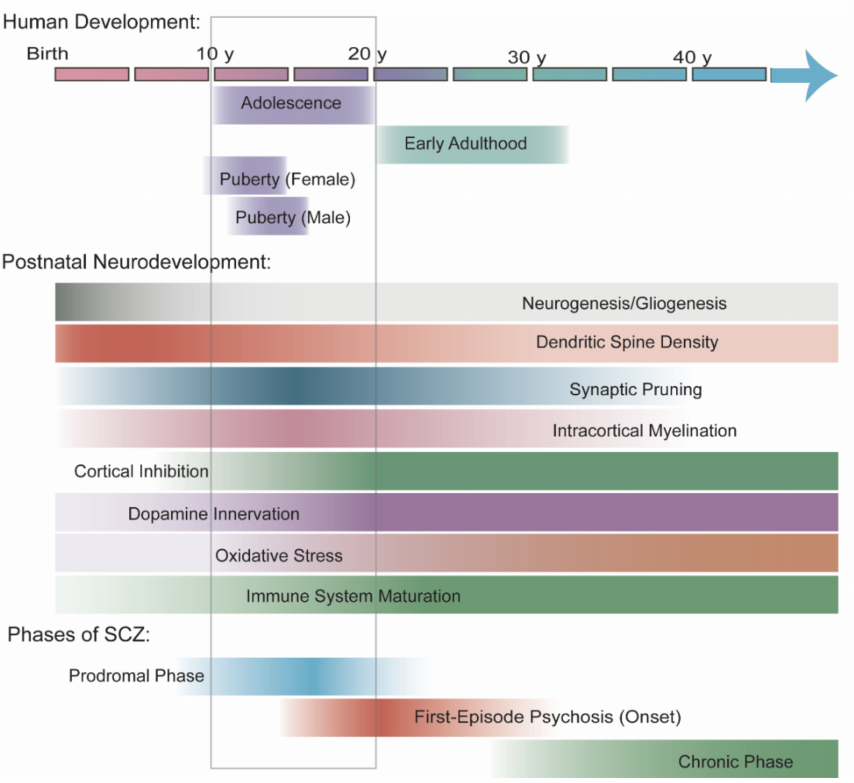
Figure 3. Overview of human postnatal neurodevelopment and the stages of SCZ. The prodromal phase of SCZ typically overlaps with adolescent development, and first-episode psychosis (and diagnosis) typically occurs in late adolescence or early adulthood. The chronic disease phase persists throughout adulthood. The onset of early SCZ symptoms during adolescence overlaps with many facets of brain maturation, including intracortical myelination, synaptic pruning, maturation of GABAergic and dopaminergic signaling in the PFC, increases in oxidative stress markers, and maturation of both the innate and adaptive immune systems. Dysregulation of any (or all) of these processes might contribute to symptom